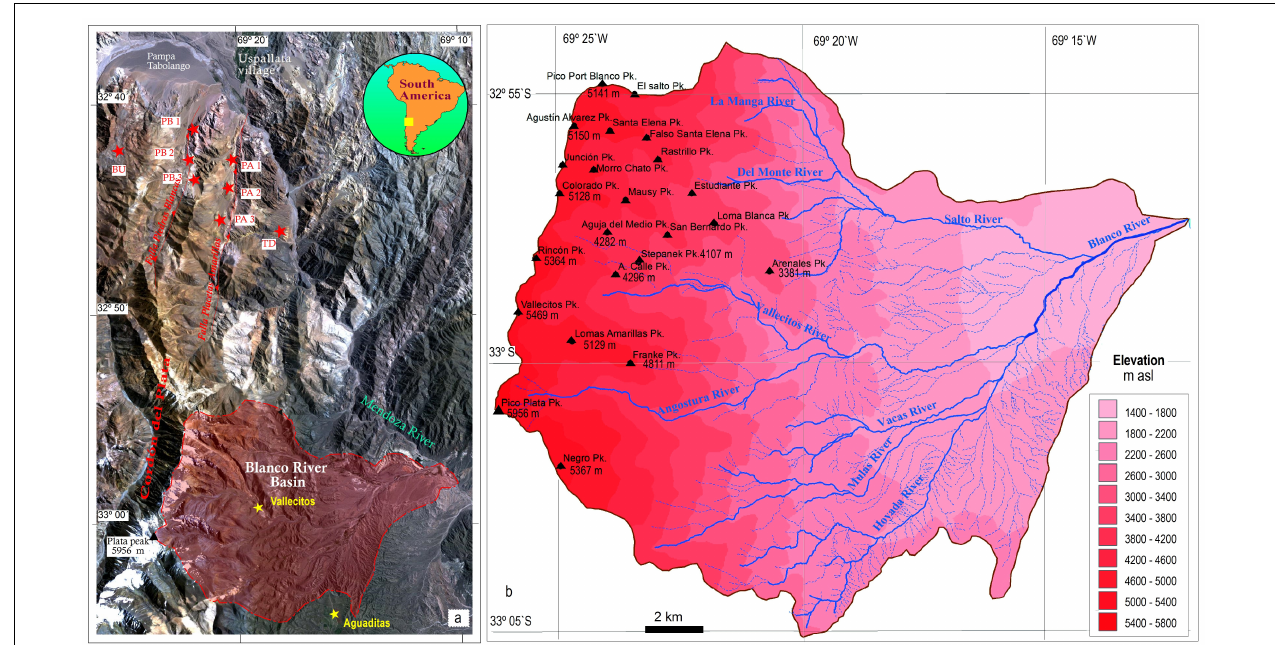
FIGURE 1 | Study area location at 33 ◦ S: (a) the Blanco River Basin (BRB) on the eastern slope of the Plata Range (polygon in red) and its relative position with a cluster of rock avalanches studied in the northern extreme of Plata Range. Rock avalanches are represented by red stars: BU, Burro rock avalanche; PB, Piedras Blancas rock avalanches: PB1, PB2, PB3; PA, Placetas Amarillas: PA1, PA2, PA3; TD, Tigre Dormido rock avalanche. Yellow stars indicate meteorological stations of Vallecitos and Aguaditas. (b) Digital elevation model of the Plata Range showing highest peaks and the catchment area of the BRB integrated by the main central branch of the Blanco River including the Angostura and Vallecitos rivers, the sub-catchments the Alto Manantiales integrated by the Salto, Manga, del Monte and Chacay rivers, and the southern subcatchment denominated Alto Las Vegas integrated by Mulas